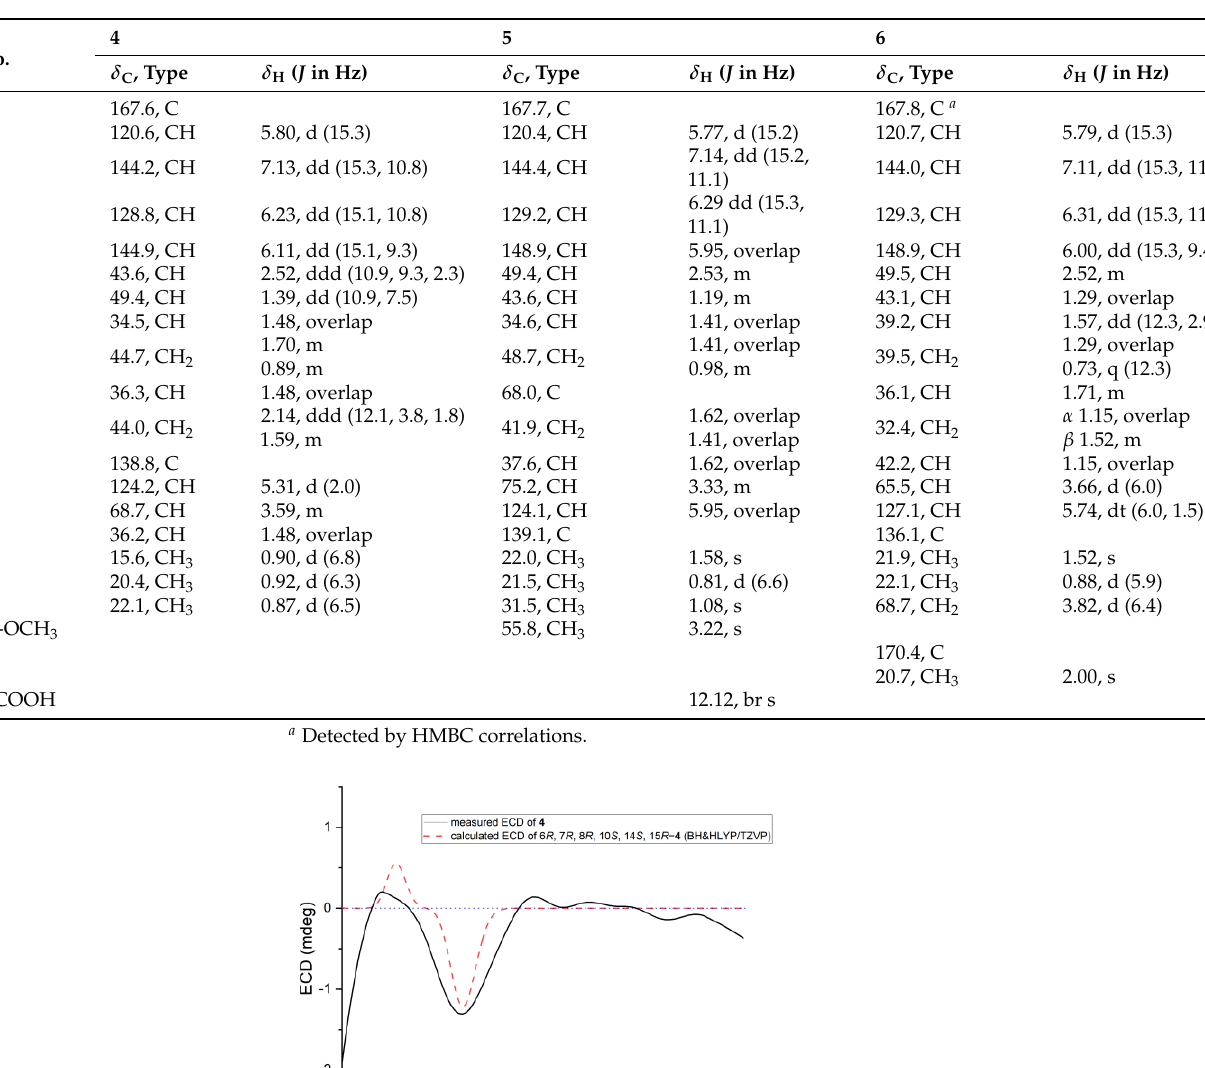
Table 2. 1 H and 13 C NMR data of compounds 4 – 6 in DMSO- d 6 .